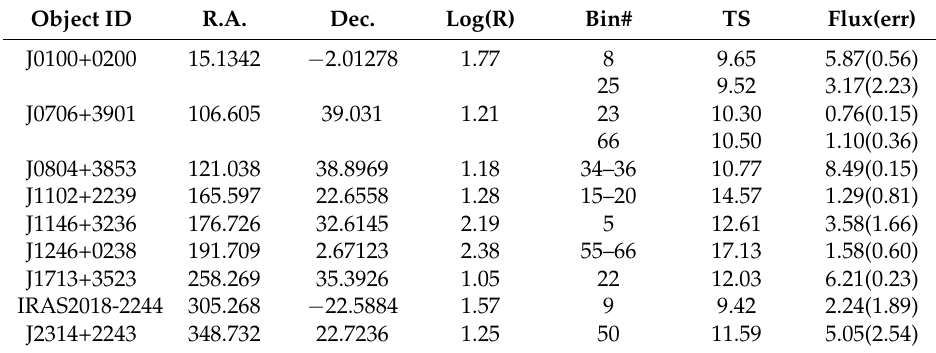
Table 2. Objects with 25 > TS > 9 gamma-ray detections. (1) Object Name; (2) Right Ascension; (3) Declination; (4) Radio-Loudness; (5) Bin Number; (6) Gamma-ray Test Statistic; (7) Gamma-ray Flux. Object ID